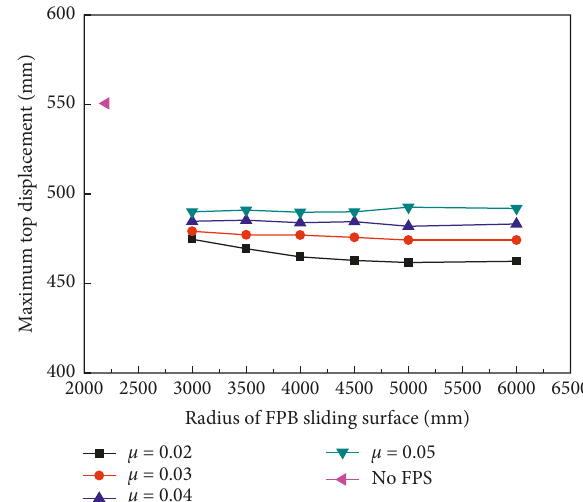
Figure 17: The maximum top displacement of T2 tower with R and μ in the X direction under L0223S